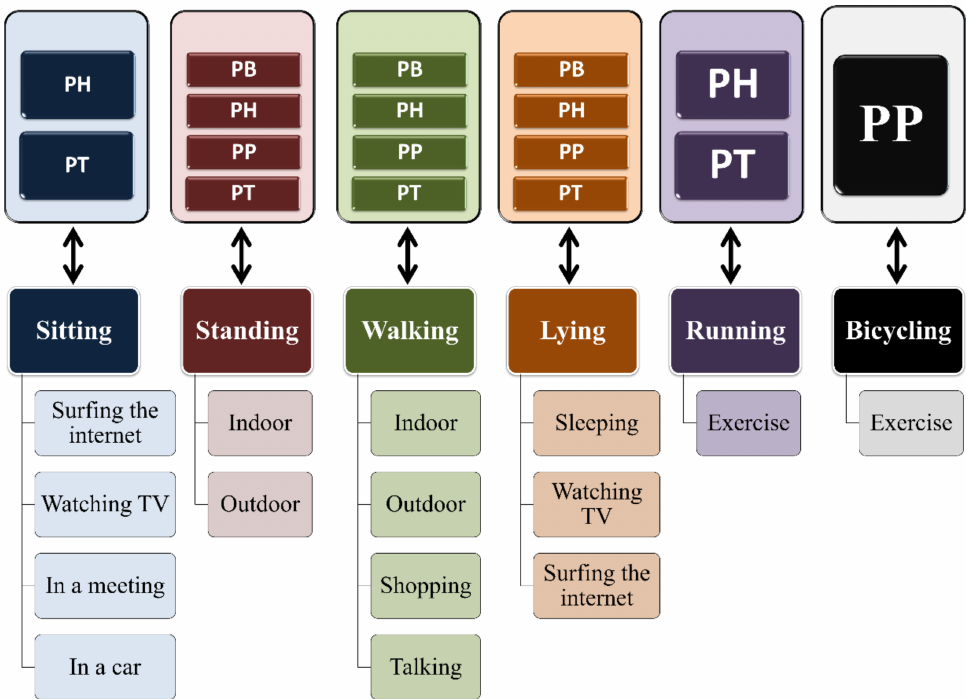
Figure 1. Primary physical activities with corresponding human behavioral contexts and phone positions, which are used for ARW. Here, PB, PH, PP, and PT represent phone in bag, phone in hand, phone in pocket, and phone on table,